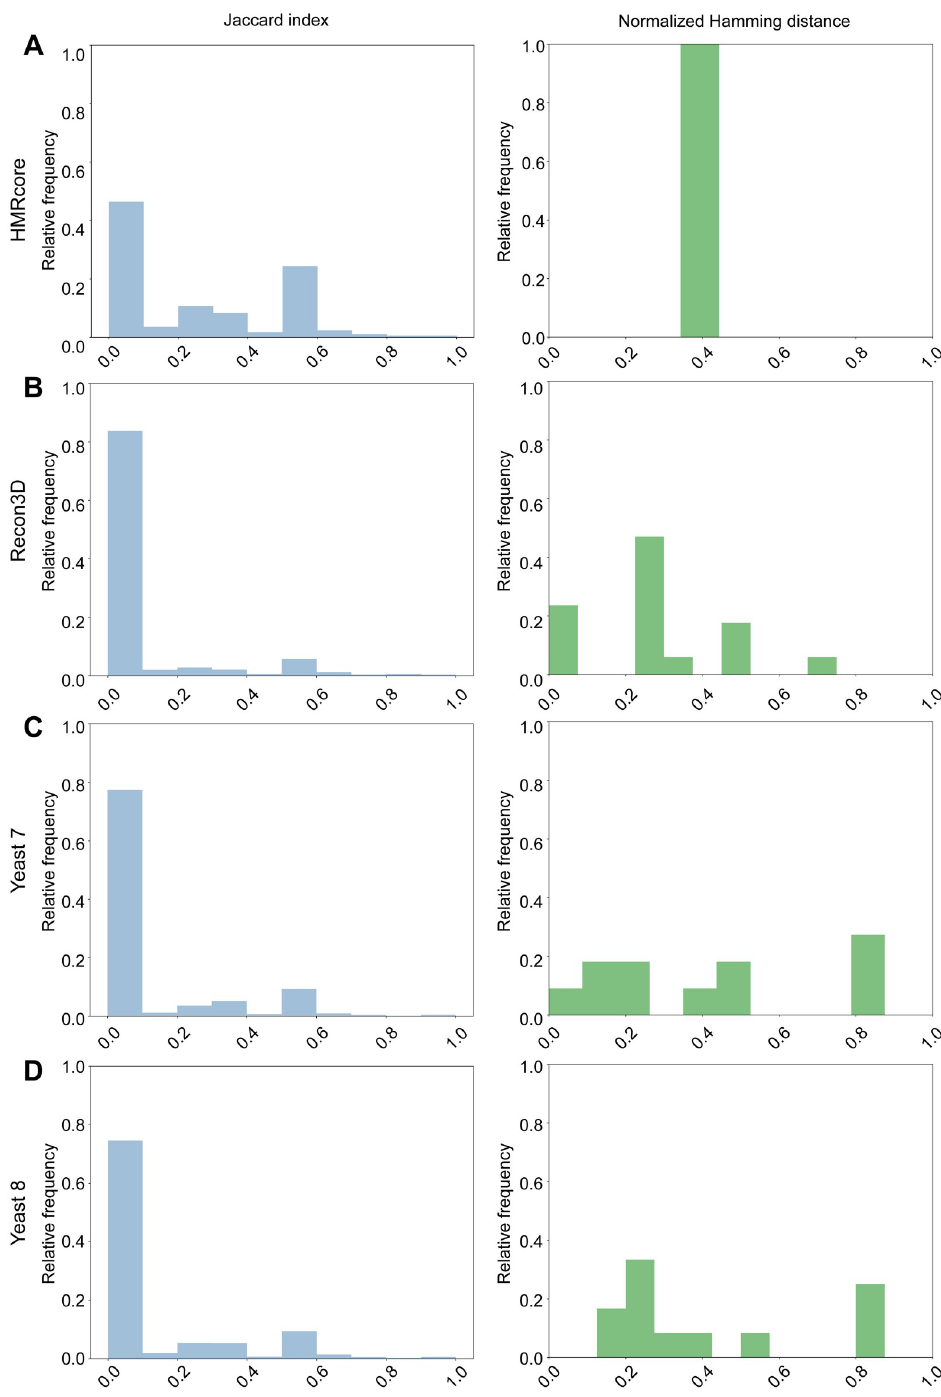
Fig 4. Evaluation of GPRuler performance in the obtained mismatches when compared with ground truth GPRs. The blue histograms on the left of each panel show the relative frequencies distribution of Jaccard indexes computed for the retrieved negative matches in all the four ground truth models. Specifically: HMRcore in Panel A; Recon3D in Panel B; Yeast 7 in Panel C; Yeast 8 in Panel D. We reported in the green histograms on the right of each panel the normalized Hamming distance between the two truth matrices of negative matches having Jaccard index of 1.